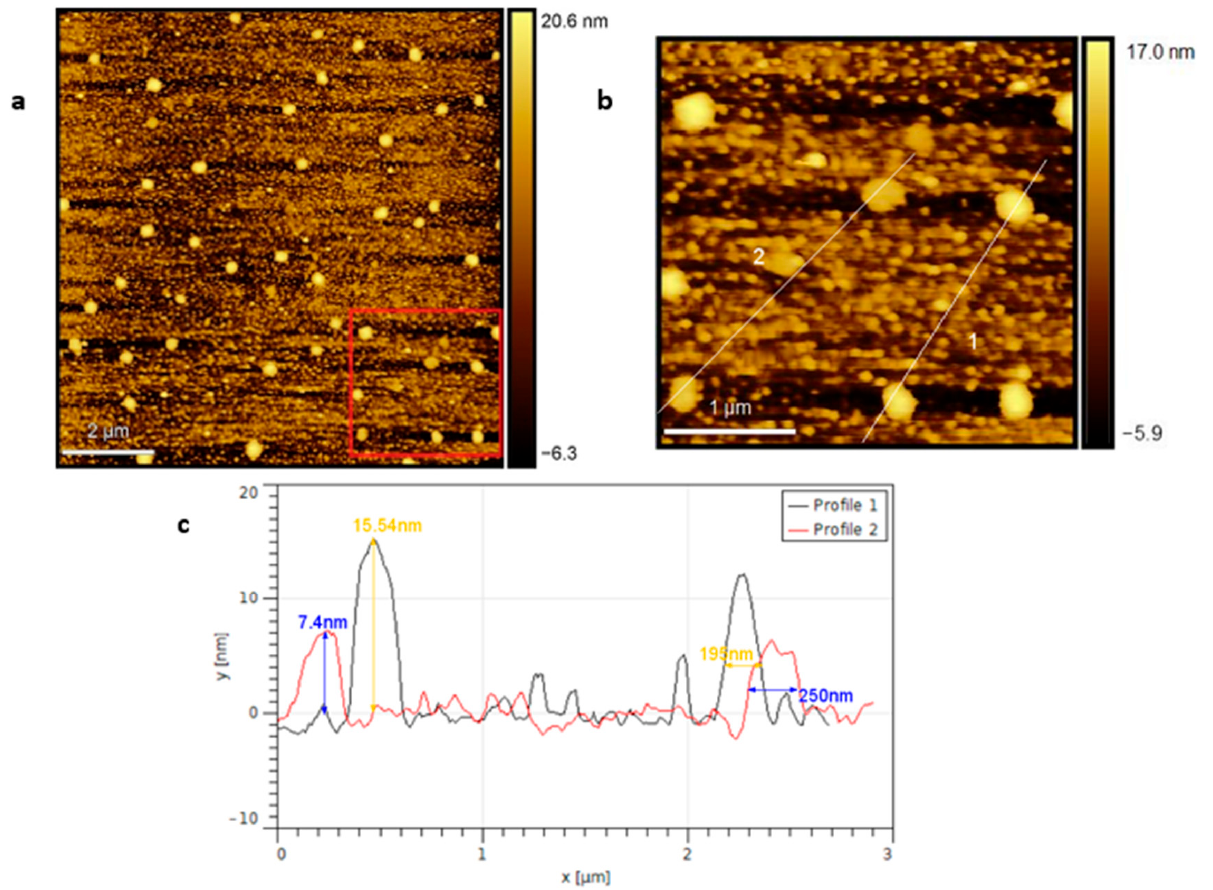
Figure 4. AFM images on 7 ML MoS 2 : ( a ) 10 × 10 µm scan. ( b ) Magnified region from red box in ( a ). ( c ) Height profiles of magnified regions along lines 1 and 2 from ( b